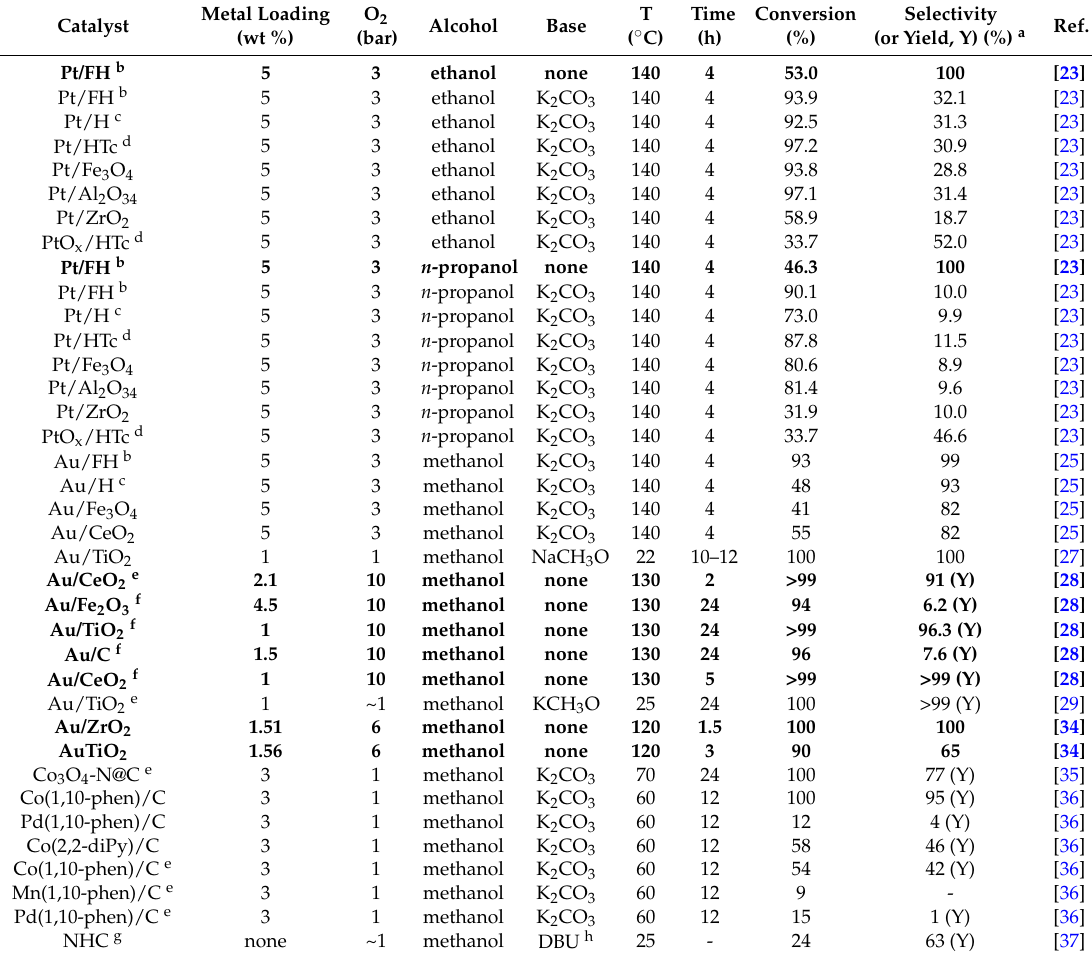
Table 1. Catalytic results and reaction conditions obtained over different